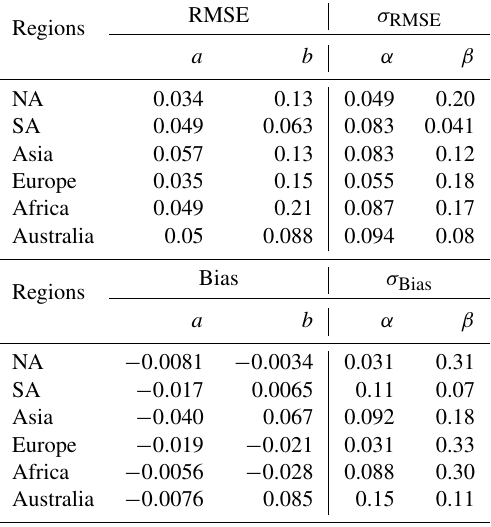
Table 5. Regional linear regression model parameters for the ex- pected error (RMSE) and bias. NA and SA stand for North and South